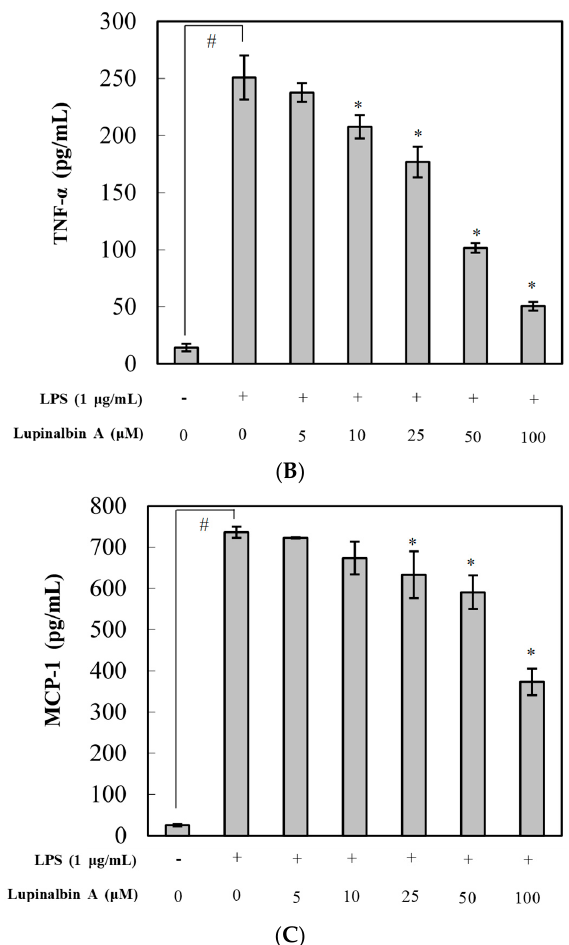
Figure 3. Effect of lupinalbin A on ( A ) IL-6; ( B ) TNF- α ; and ( C ) MCP-1 production in LPS-treated RAW264.7 cells. The cells were treated with various concentrations of lupinalbin A (5–100 µM) for 2 h and then stimulated with LPS (1 µg/mL) for 18 h. IL-6, TNF- α , and MCP-1 production